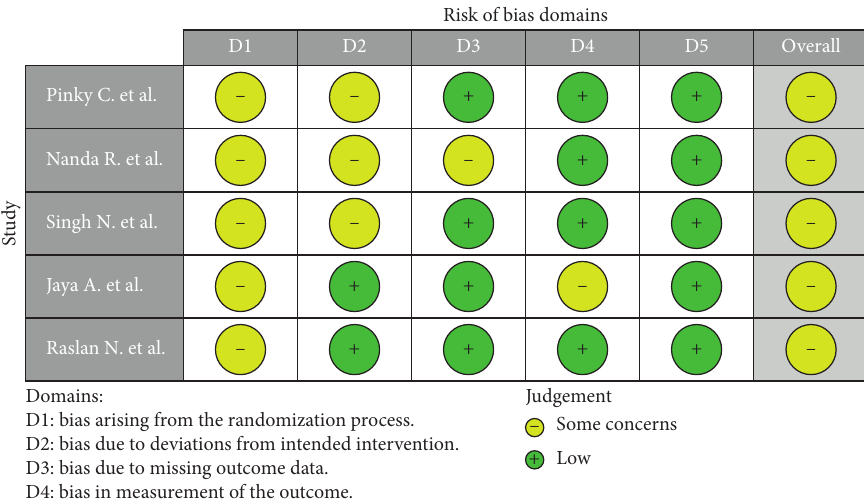
Figure 1: Prisma flow